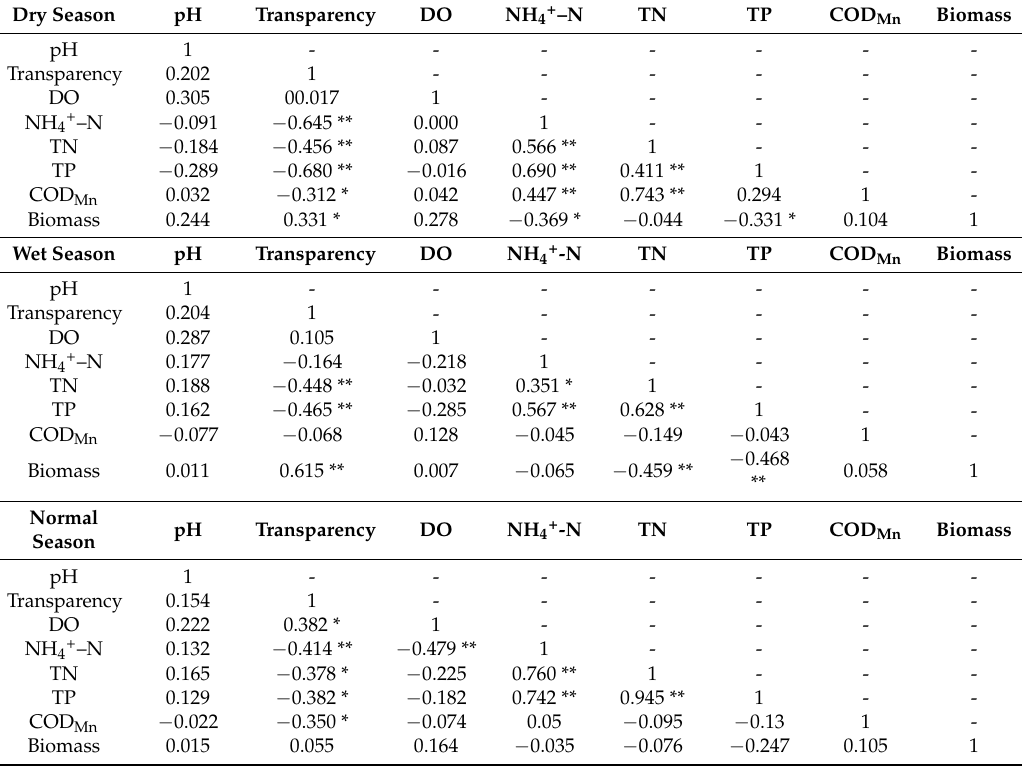
Table 3. Correlation coefficients between biomass and water quality parameters.